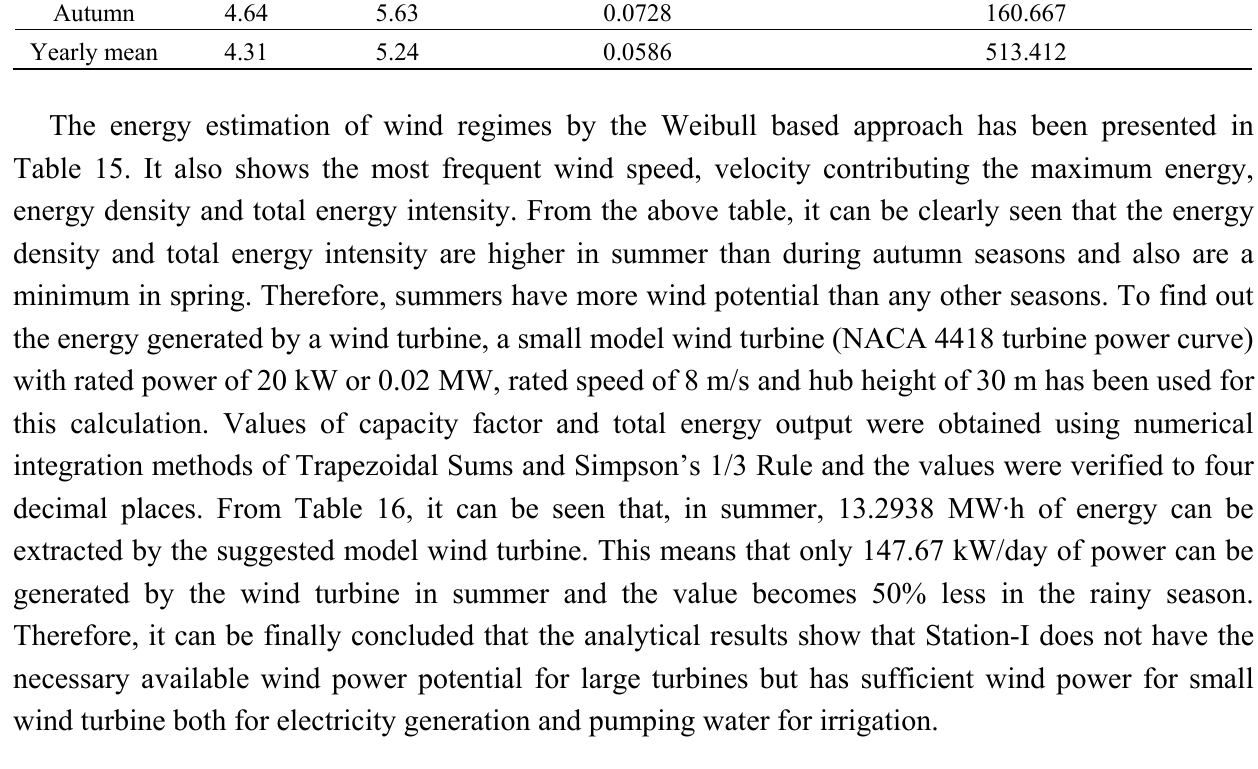
), velocity contributing the maximum Fmax ) and total energy intensity ( E ). D DT